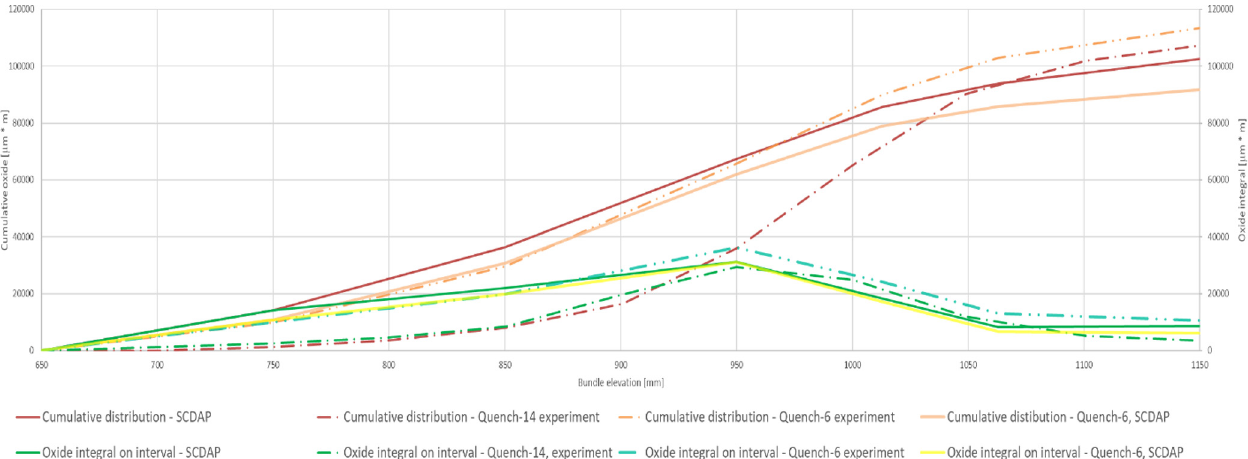
Fig. 9. Cumulative distribution and integrated oxide thickness of corner rod after test made out of